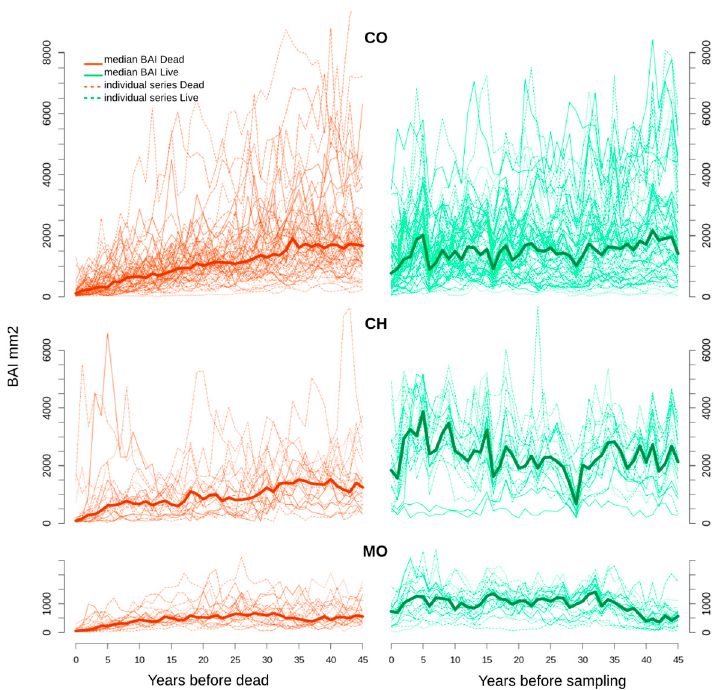
Figure 4. BAI chronologies from dead (orange) and living (green) trees at the three sites (solid lines). Dashed, thin lines represent the BAIs from each tree.